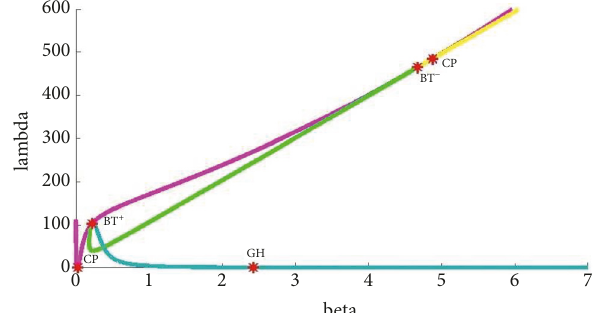
Figure 8: Bifurcation diagram on the (𝛽,𝜆) plane. The blue (yellow) curve represents subcritical (supercritical) Hopf bifurcation, the magenta curve represents saddle-node bifurcation, and the green curve is a neutral saddle curve.